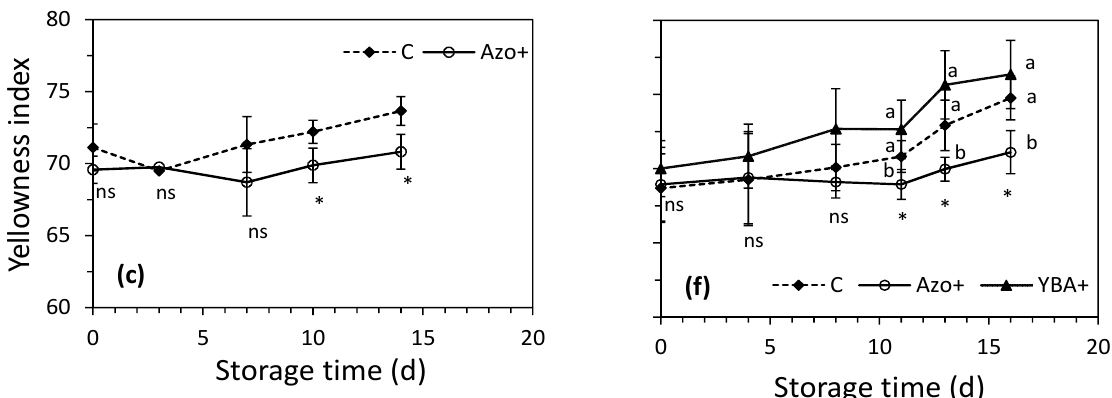
Figure 2. Trend of the visual appearance, odor and yellow index during the storage of the wild rocket treated with Azoxystrobin (Azo +) at preharvest in Exp 1 ( a – c ), and with Azoxystrobin or an algae-based biostimulant (YBA+) in Exp 2 ( d – f ), and of that relating to the untreated control (C). Vertical bars indicate SD (n = 3). ns, * and ** indicate F test not significant, significant at P ≤ 0.05 and significant at P ≤ 0.01, respectively. Separation of mean within the days from the start of storage by SNK test ( P = 0.05). Different lower case letter denotes significant differences.